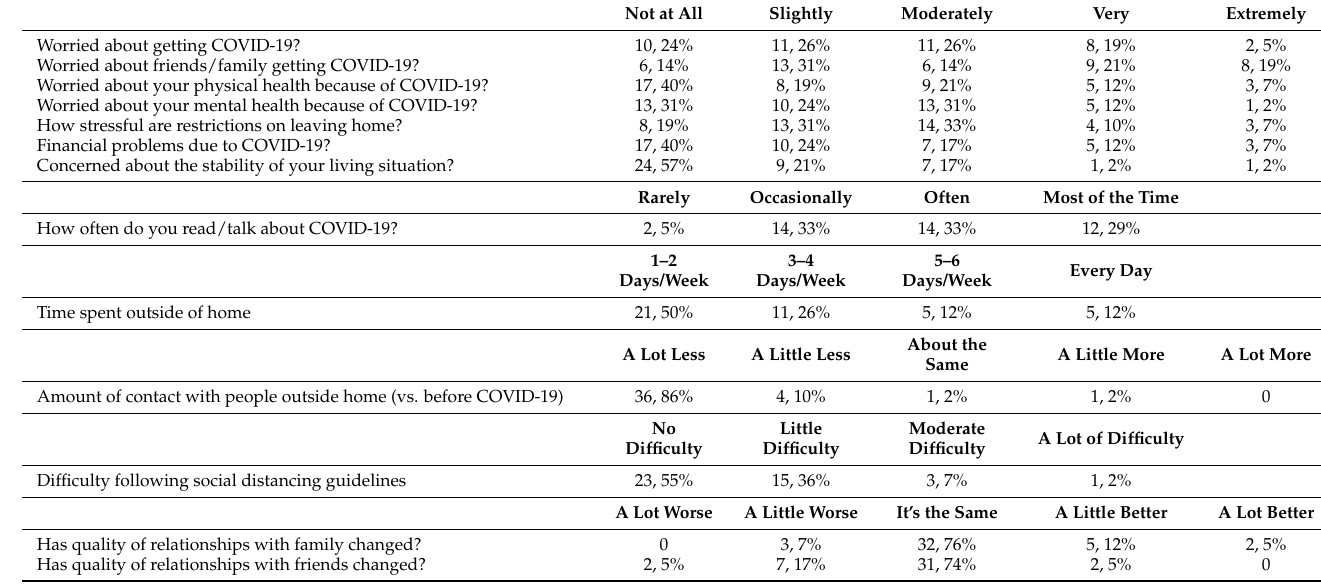
Table 2. Impact of COVID-19